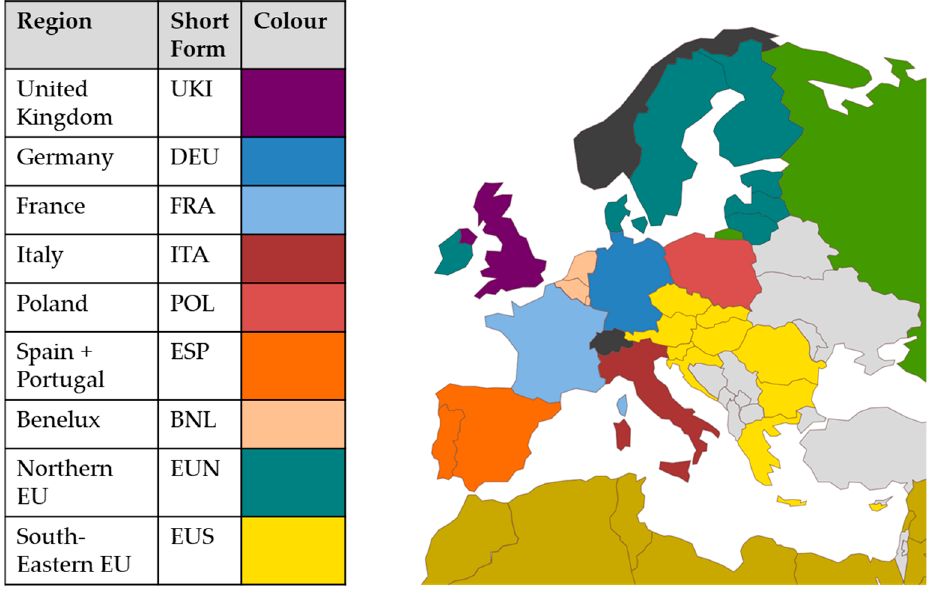
Figure 2. NEWAGE regions in EU 27 + the United Kingdom.